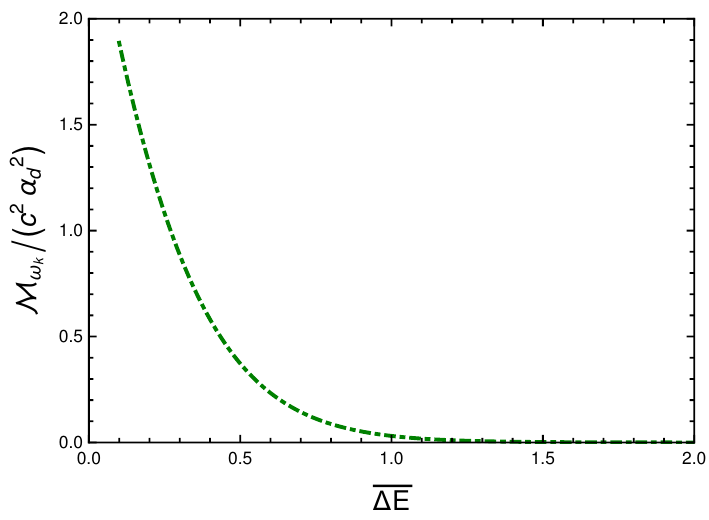
( ρ ) / ( c 2 r 2 ) perceived by two out going null detectors AB H k ∆ E for fixed frequency of the field modes d = α = 1 , α = ω 2 and d/α = 1 k d ω k d k x k / d